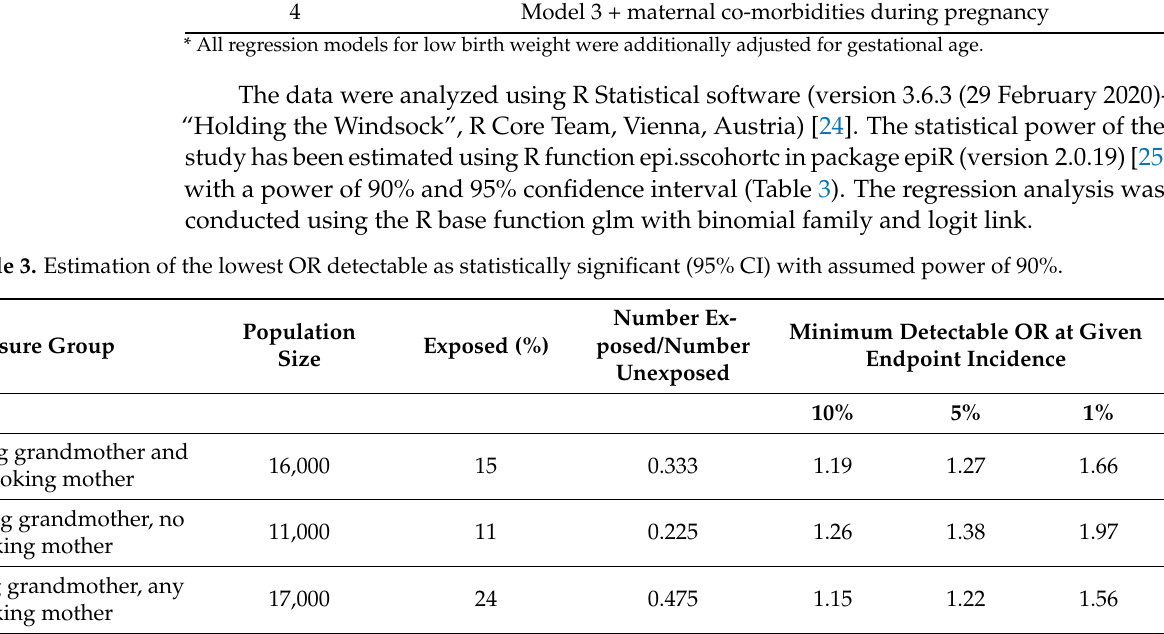
Number Ex- Population Minimum Detectable OR at Exposed (%) posed/Number Size Unexposed